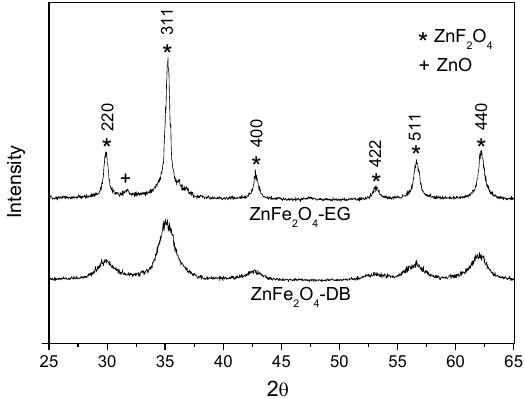
Figure 1. XRD patterns of the samples prepared with different solvent